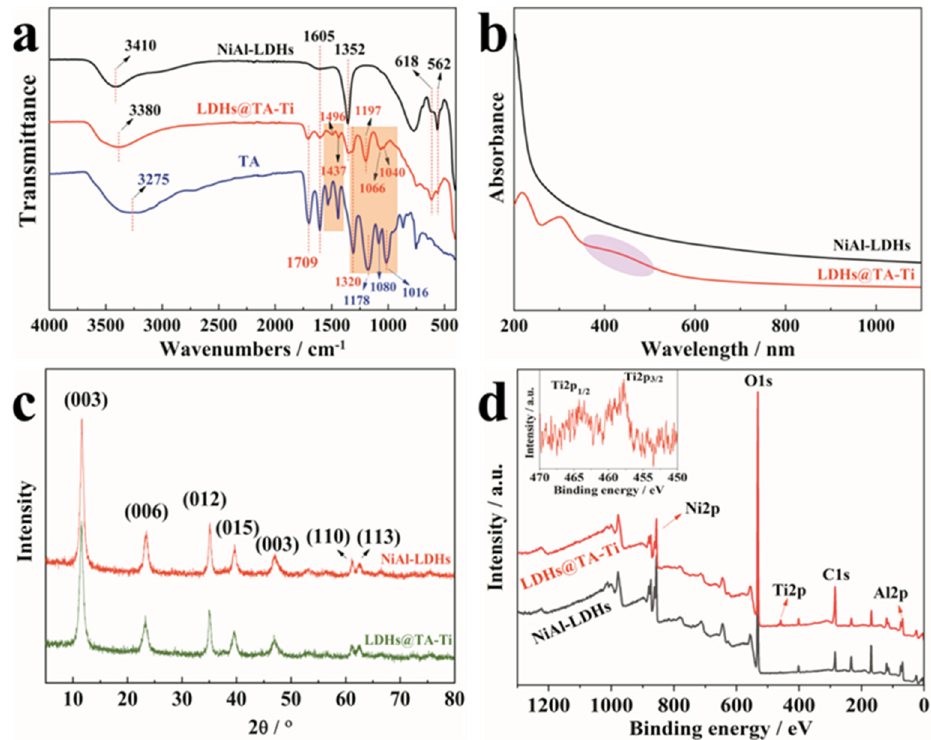
Figure 1. ( a ) FT-IR spectra, ( b ) UV–Vis spectra, ( c ) XRD patterns and ( d ) XPS spectra of NiAl-LDHs and LDHs@TA-Ti.